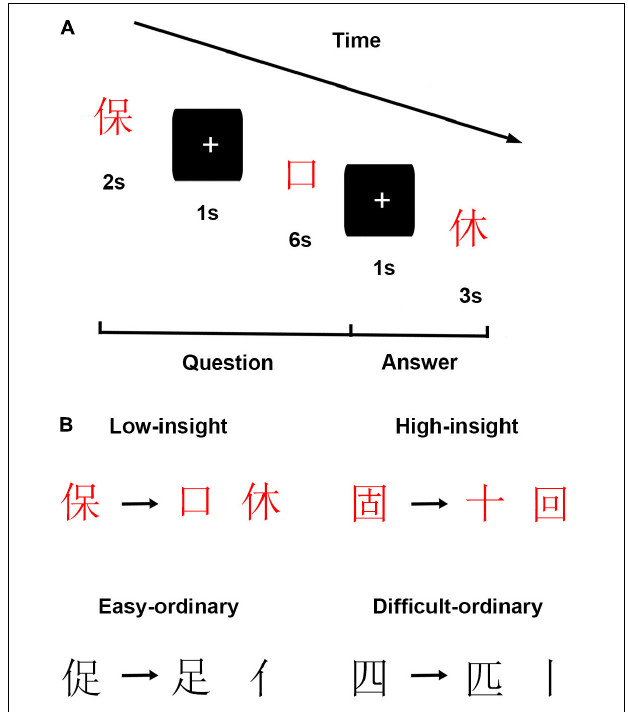
FIGURE 1 | Schematic of experimental design. (A) Experimental procedures. (B) Exemplars of each condition in insight and filler